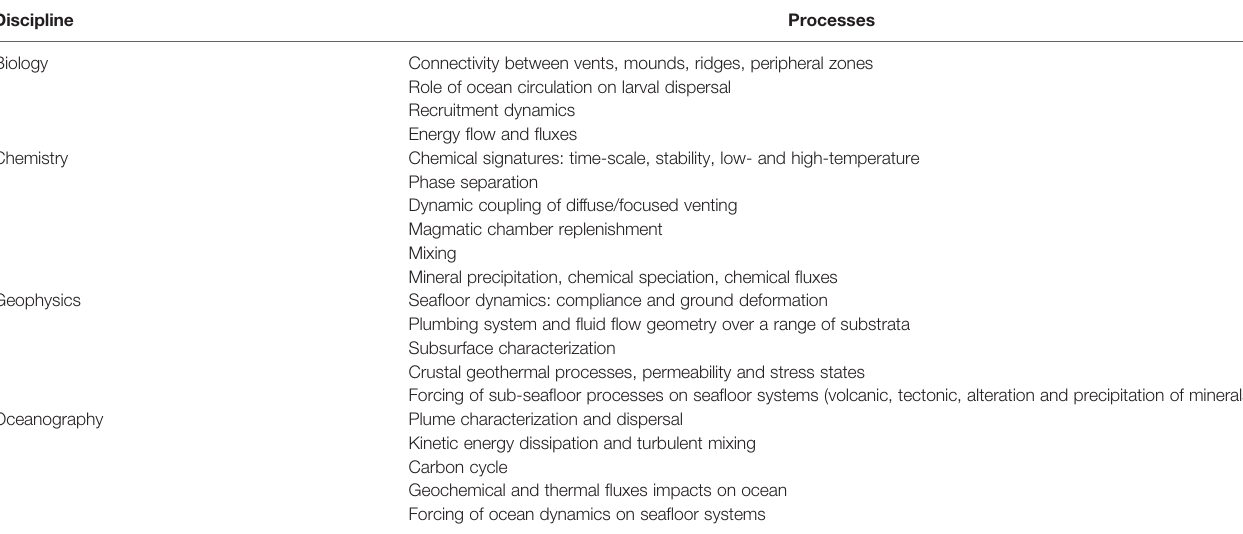
TABLE 1 | Themes and processes to be considered at vents as de fi ned during the fi rst workshop and that can be addressed through observatories and their associated maintenance cruises.